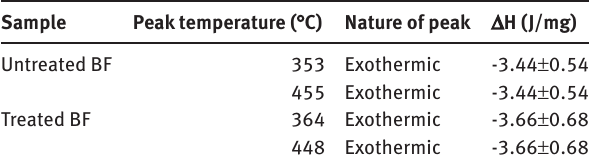
the structure transformation induced by thermal